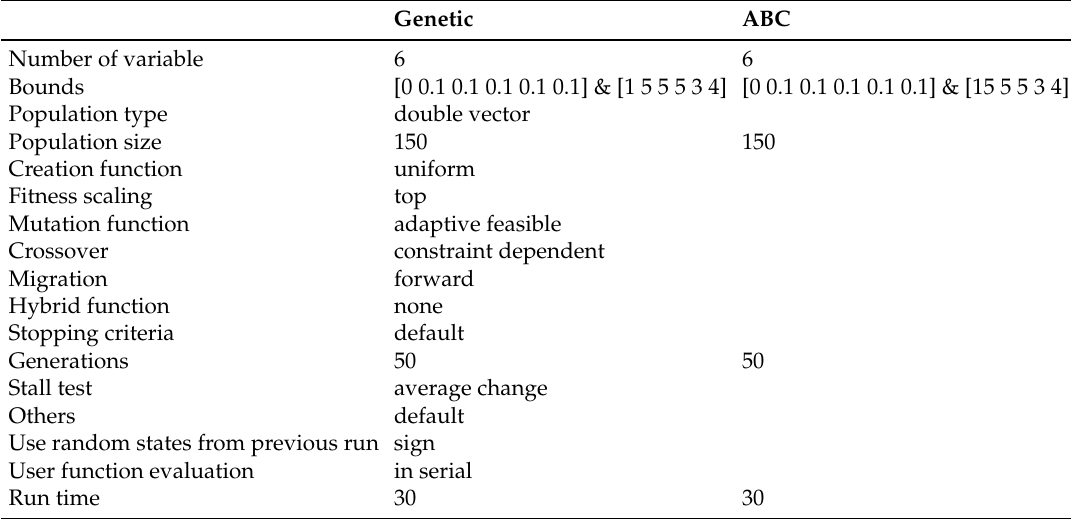
Table 2. Configuration of both